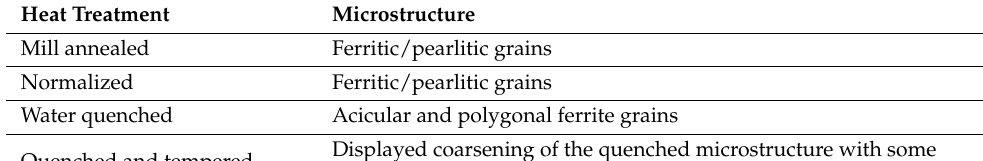
Table 8. Different microstructures of the exposed X70 samples. Data from [24].